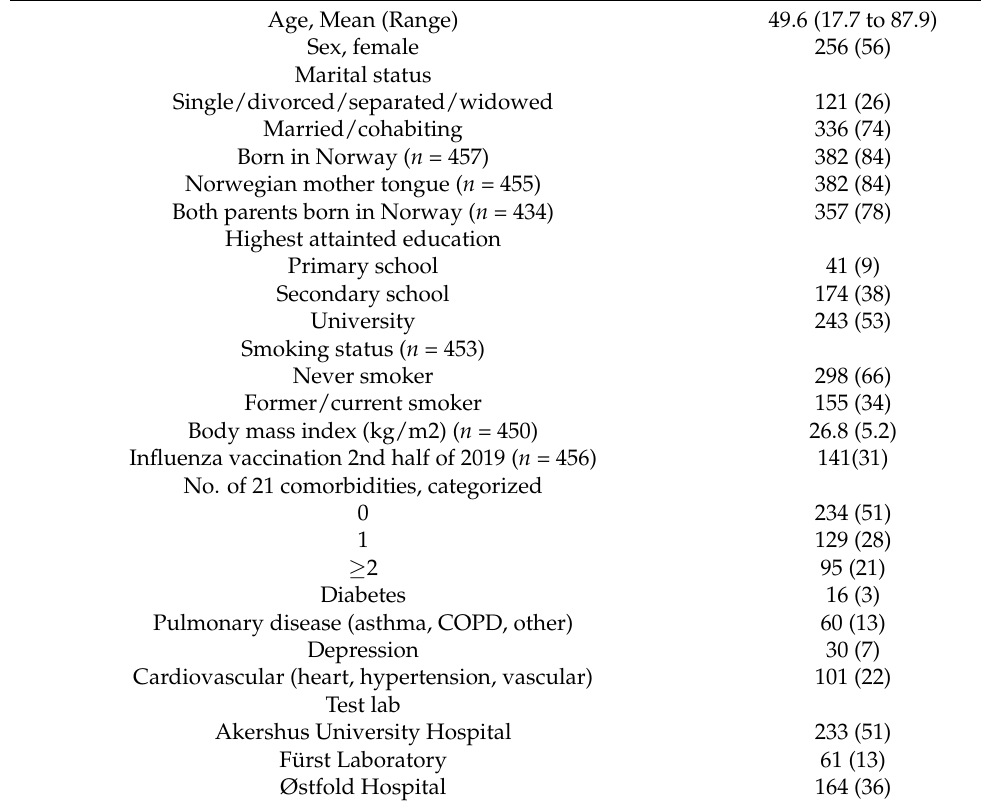
Table 1. Respondent characteristics ( n = 458). Number (%), unless specified